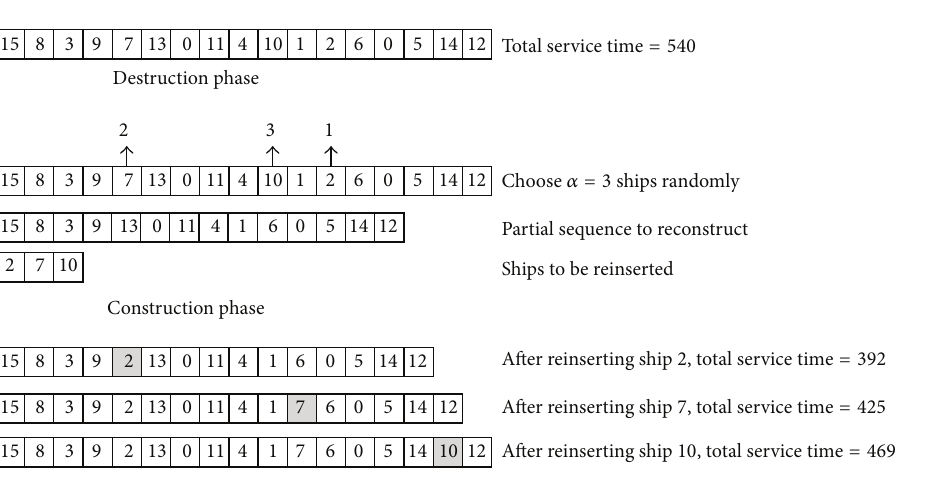
Figure 2: An example of IG destruction phase and construction phase.